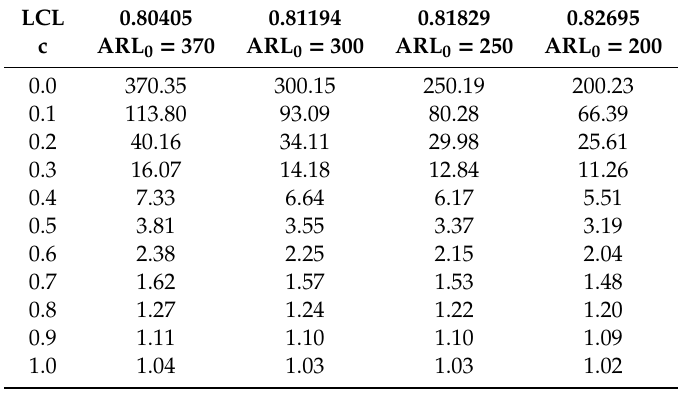
Table 4. The ARLs for the proposed chart when n = 50, WD (1.8,2.0), USL = 5.0504, and LSL = 0.1055.